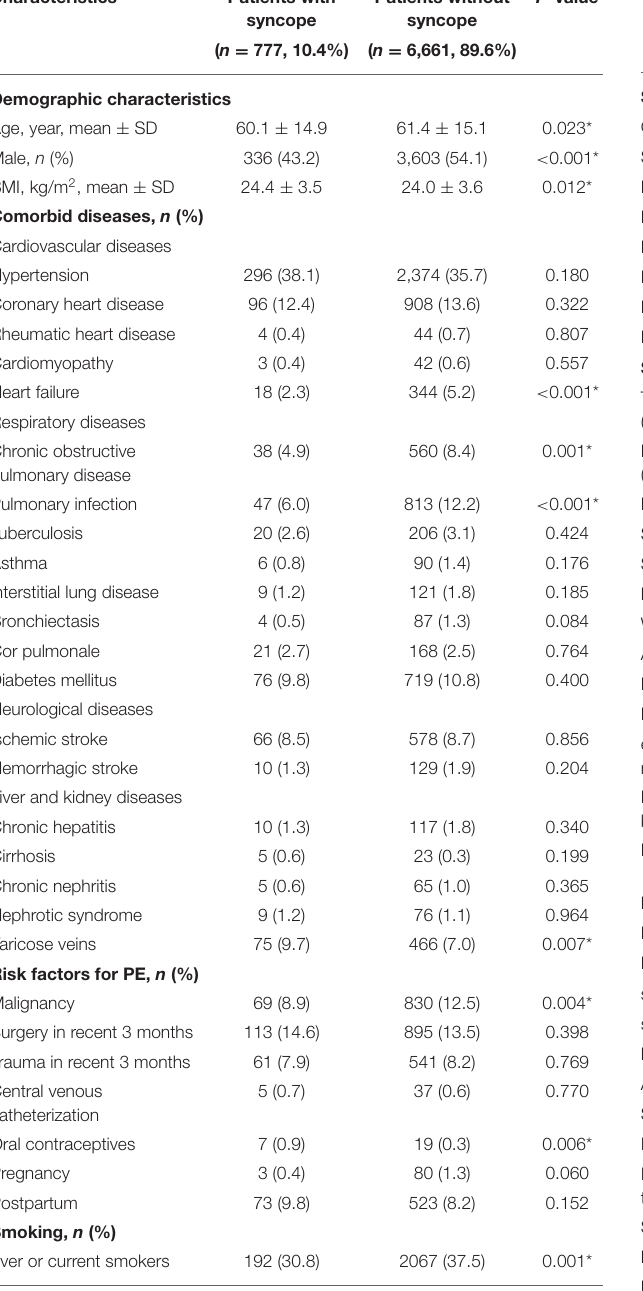
TABLE 2 | Clinical presentation, initial treatment, and clinical outcomes of patients with acute